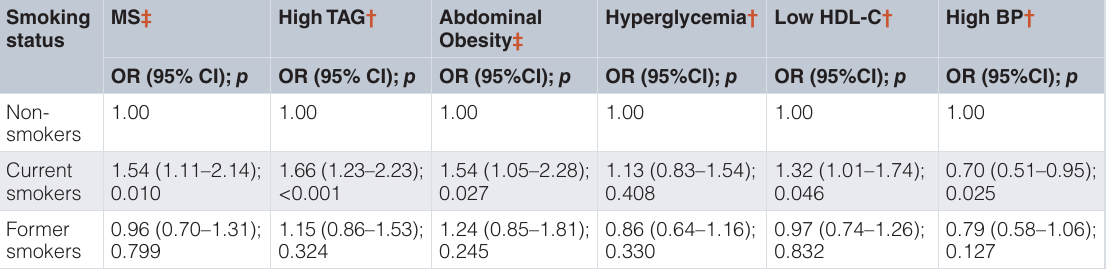
Table 3. Adjusted OR for metabolic syndrome and its components according to smoking habit in Maracaibo, Venezuela. Smoking status